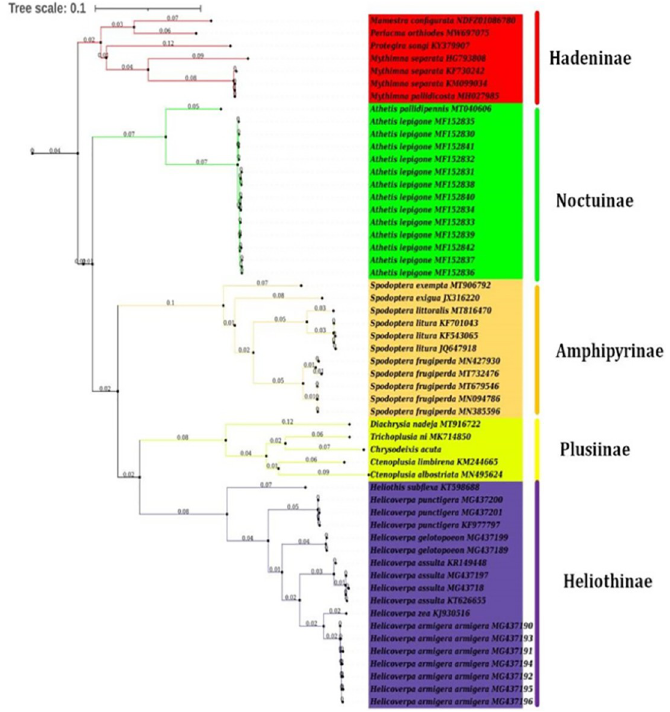
Fig 5. Phylogenetic tree of 55 species from Noctuidae family species including Chrysodeixis acuta . The analysis obtained from Bayseain Inference and Maximum Likelihood based on concatenated data of 13 PCGs genes. The numbers at nodes indicate ML bootstrap values probabilities. Accession numbers are given for species obtained from GenBank.